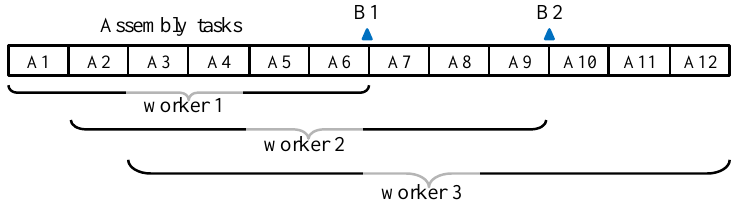
Figure 5. Task assignment of workers in the proposed BB assembly (ABB) cell. B1 and B2 indicate the buffers.